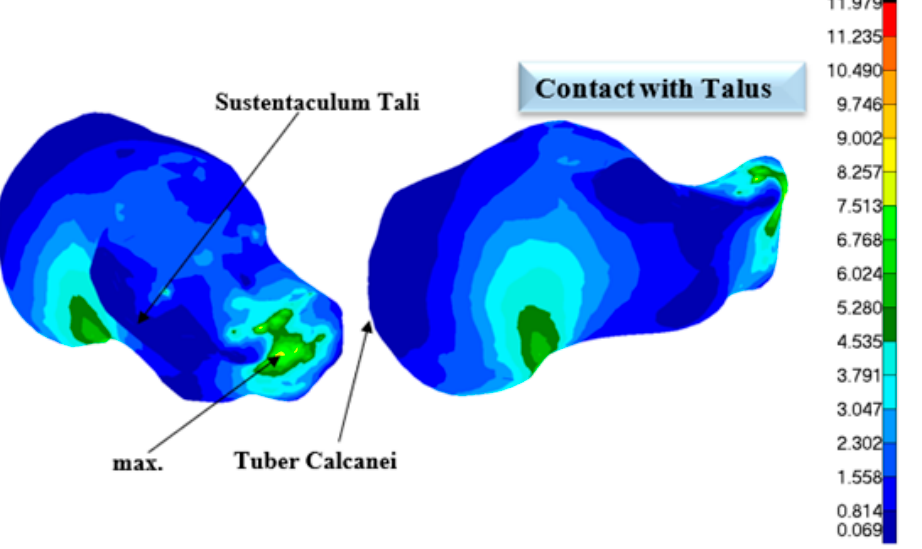
Figure 12. Distribution of the reduced stress on the healthy heel bone produced from CT images, according to the HMH/MPa/hypothesis.